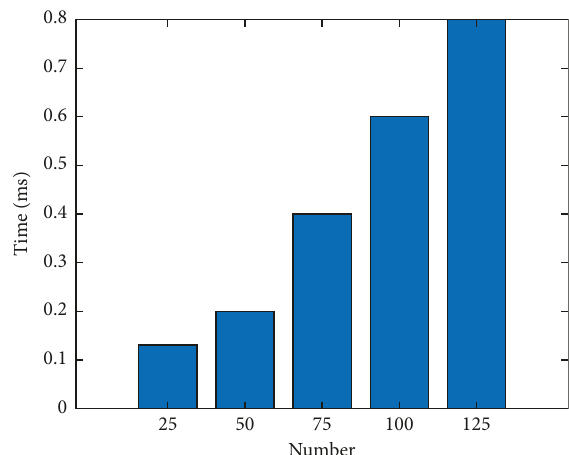
Figure 8: Time to create a block. Figure 9: Time to validate a block. Calculate overhead in the system. The expenses of interaction between remote facility and patients and the operational expenses of smart contracts are quantified by Ethereum gas.